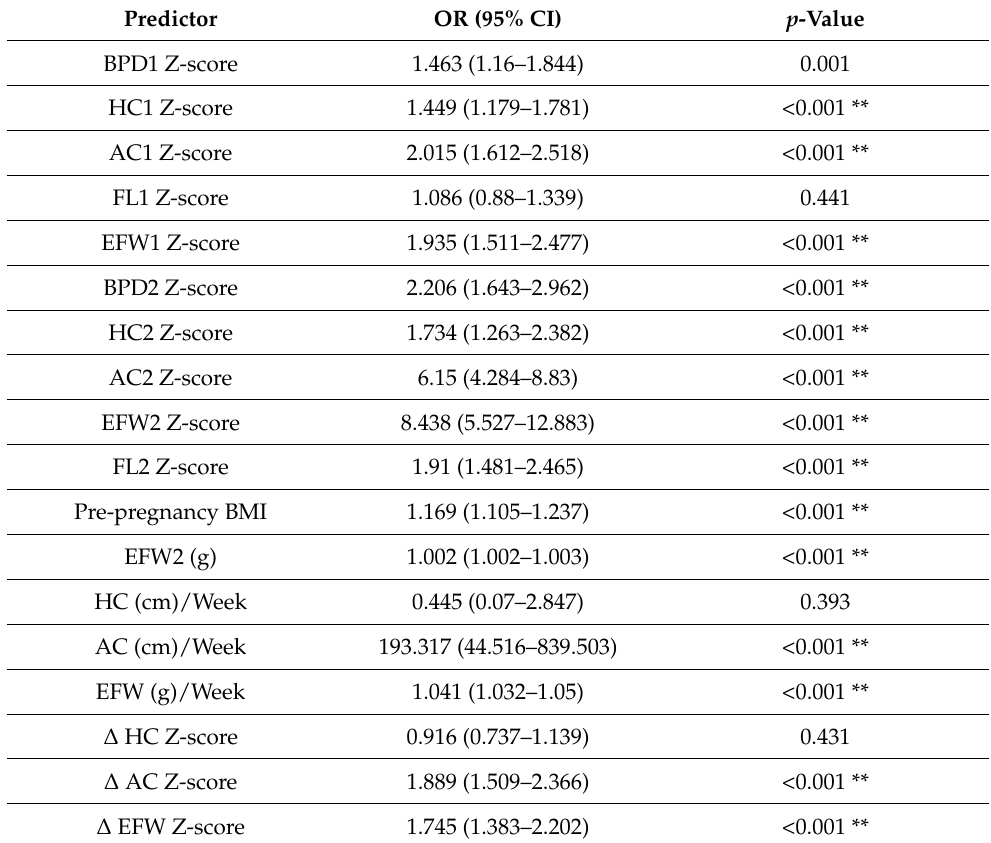
Table 2. Result of univariable binary logistic regression analysis using type (LGA vs. AGA) according to gestational